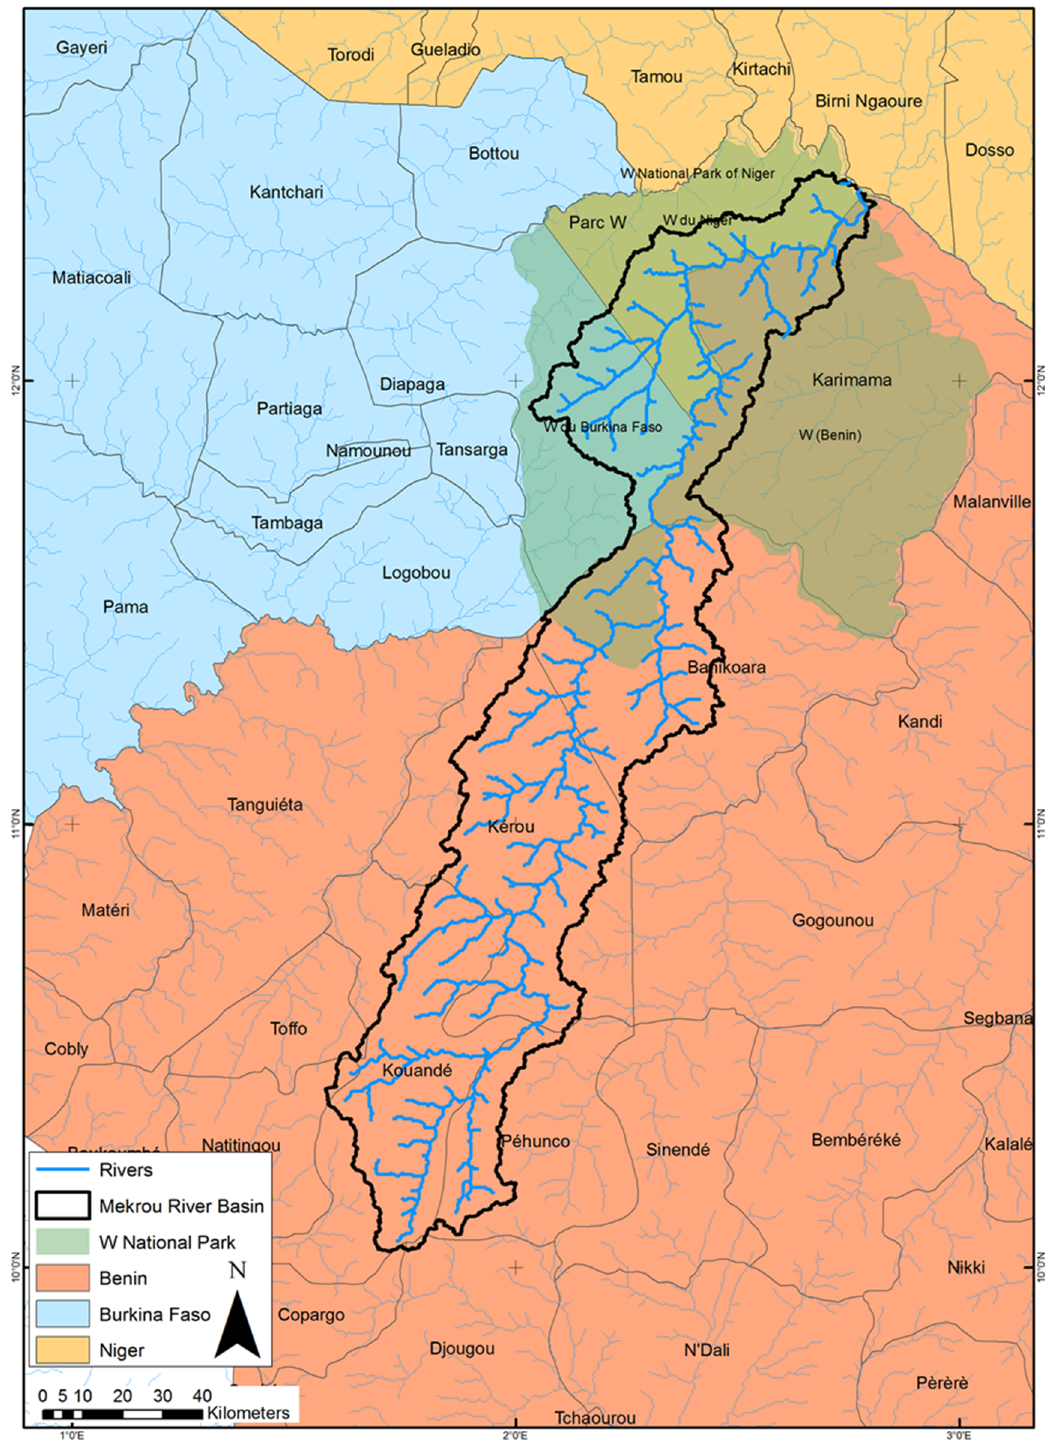
Figure 1. Location of the Mékrou River Basin.